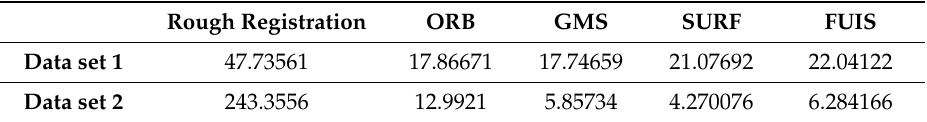
Table 3. Mean deviation of di ff erent methods’ stitching result